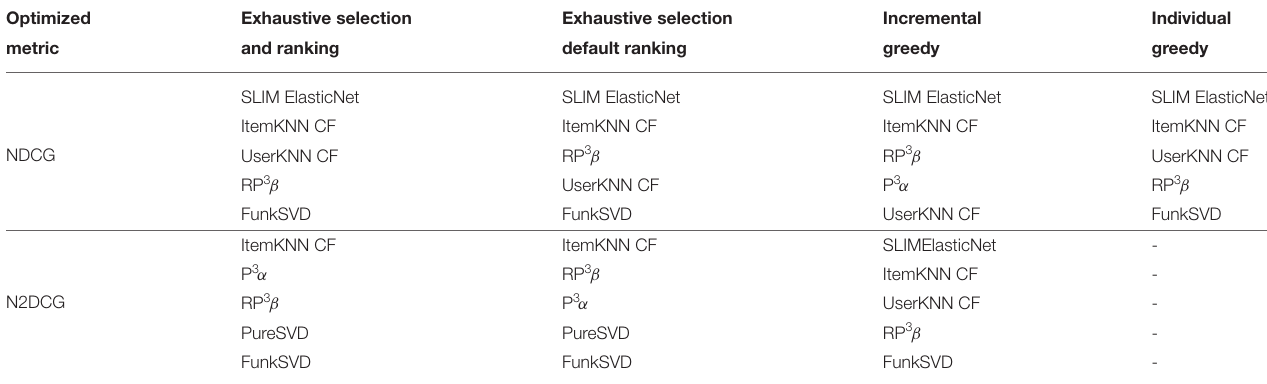
TABLE 6 | Layouts of 5 carousels selected for the ContentWise Impressions dataset selected according to different strategies and optimizing both the single list NDCG and the proposed two-dimensional